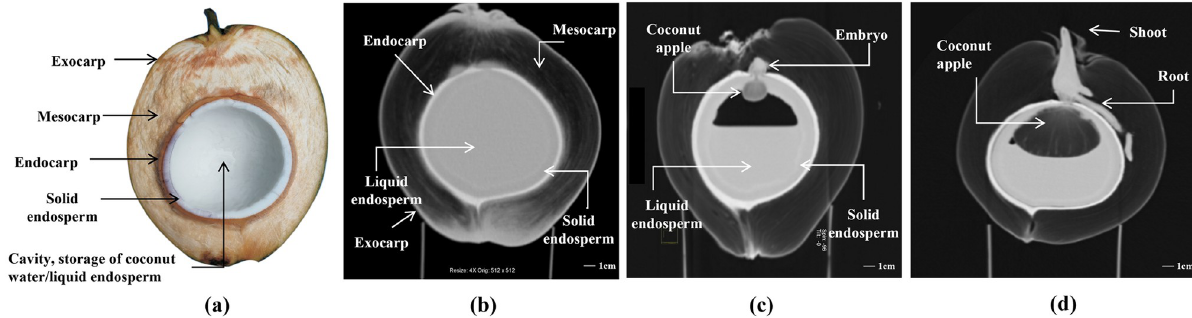
Fig 2. A physical photo of cut coconut and three computed tomography multiplanar reformation images of different coconuts.